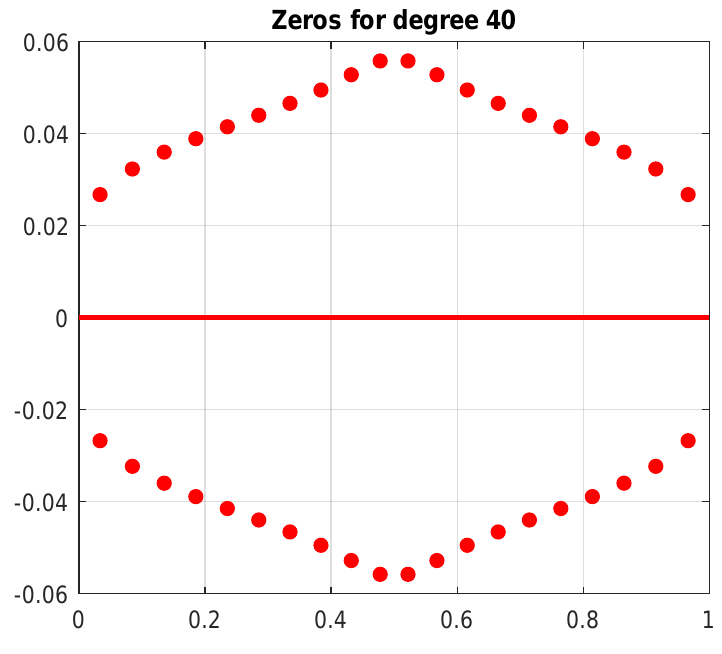
Figure 5. Univariate Poles for Degree n = 40.